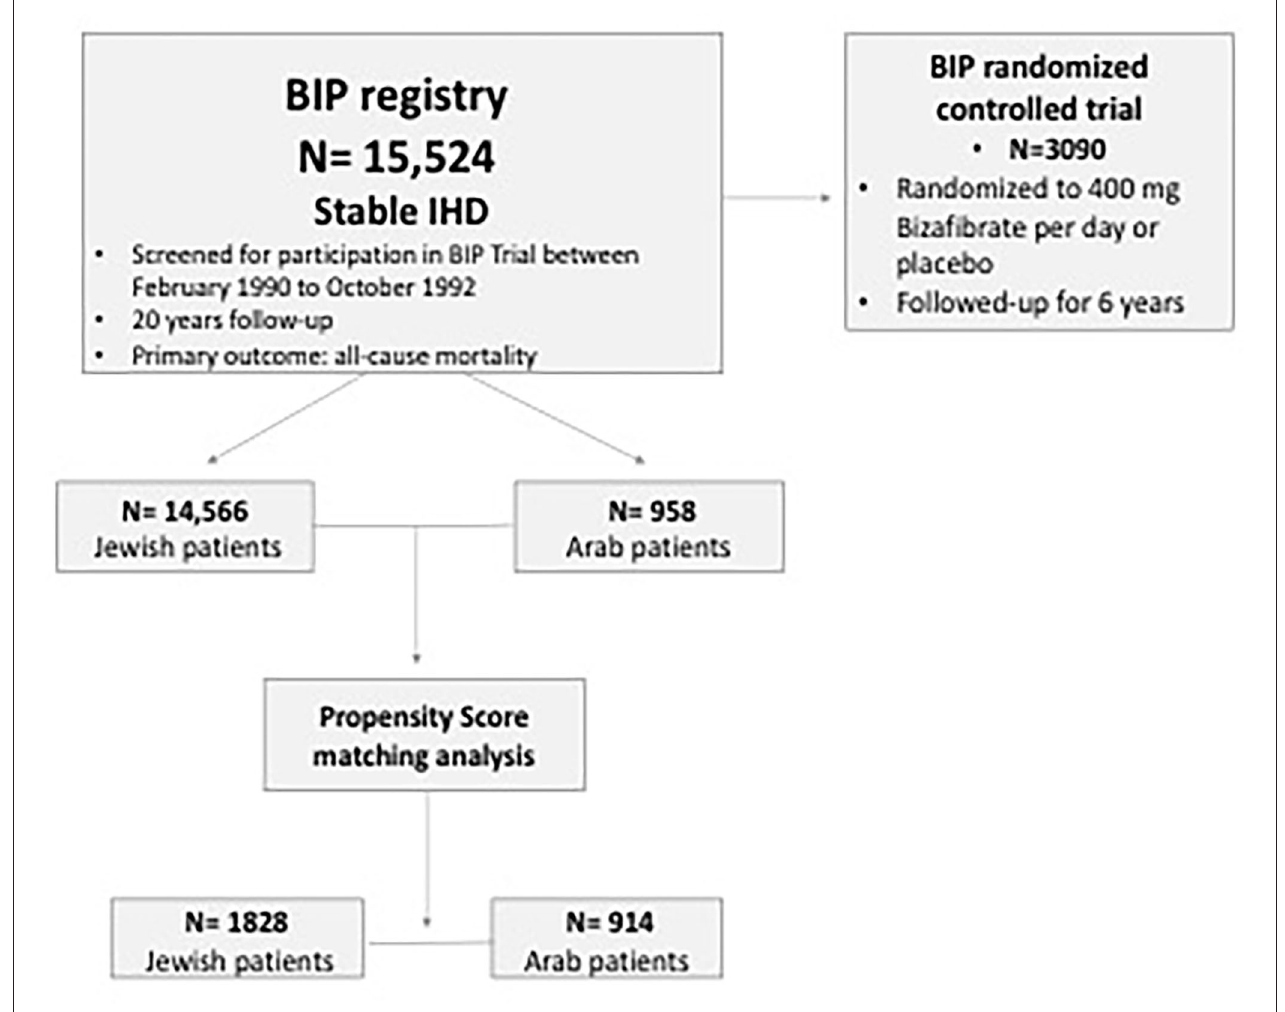
FIGURE 1 | Study flow chart. BIP, Bezafibrate Infarction Prevention; IHD, ischemic heart